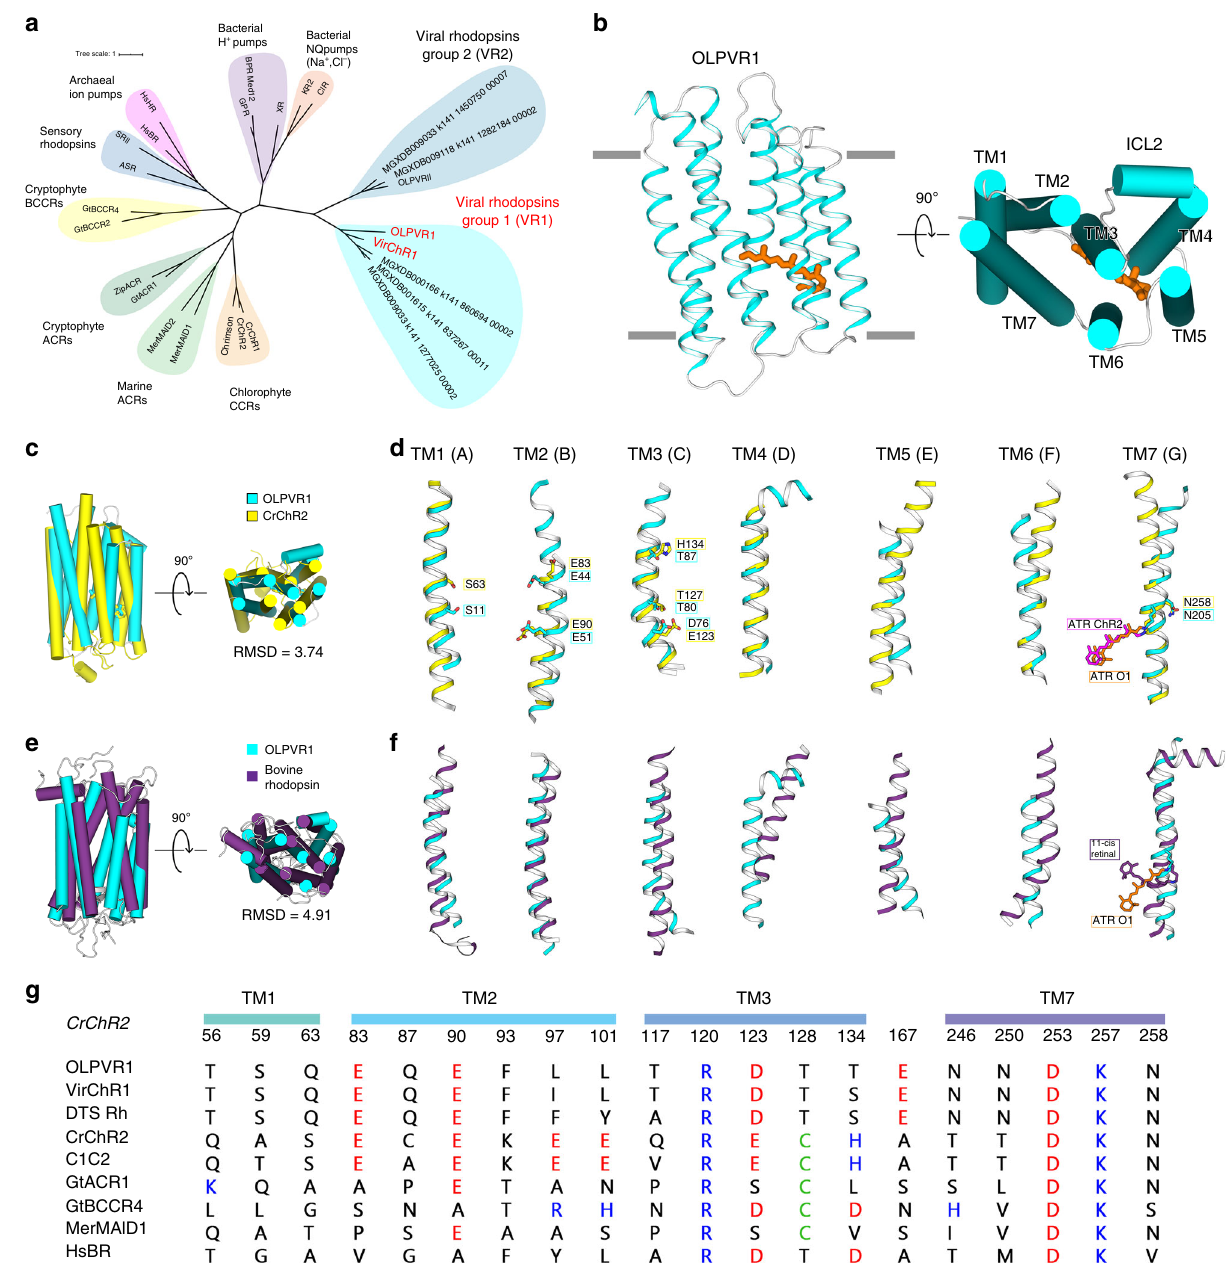
Fig. 1 Phylogenetic and structural overview of the viral channelrhodopsins group. a Unrooted phylogenetic tree of the channelrhodopsin superfamily, including viral channelrhodopsin representatives. Scale bar indicates the average number of amino acid substitutions per site. CCR, cation-conducting channelrhodopsin, ACR, anion-conducting channelrhodopsin. OLPVR1 and VirChR1 proteins are additionally indicated in red. Rhodopsins were named according to the previous works 18,101,102 . b Crystal structure of OLPVR1 protein, viewed parallel to membrane (left), and from the extracellular side (right). All- trans retinal (ATR) is depicted with orange sticks. The hydrophobic membrane boundaries were calculated with the PPM server and are shown by gray lines 103 . c Structure alignment of OLPVR1 and Cr ChR2 (PDB ID: 6EID 104 ) structures colored cyan and yellow, respectively. RMSD, root mean square deviation of atomic positions. d Individual TM helices are shown after the superimposition of the OLPVR1 and Cr ChR2 rhodopsins. e Structure alignment of OLPVR1 and bovine rhodopsin (PDB ID: 1U19 43 ) structures colored cyan and purple, respectively. f Individual TM helices are shown after the superimposition of the OLPVR1 and bovine rhodopsin. g Alignments of functionally important residues of transmembrane helices 1, 2, 3, and 7 of representative proteins from channelrhodopsin subfamilies. Positively and negatively charged residues are highlighted blue and red; cysteine residues are highlighted